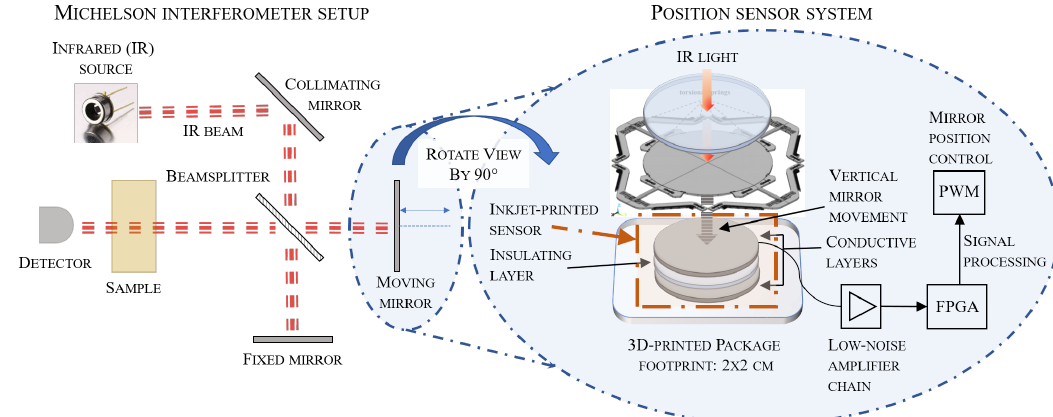
Figure 1. The basic construction principle of a Michelson interferometer is schematically illustrated. On the right, the suggested mirror position sensing system is shown. It is composed of a multilayer inkjet-printed capacitive sensor followed by a Low-Noise Amplifier (LNA) analog font-end and all digital signal processing on a Field Programmable Gate Array